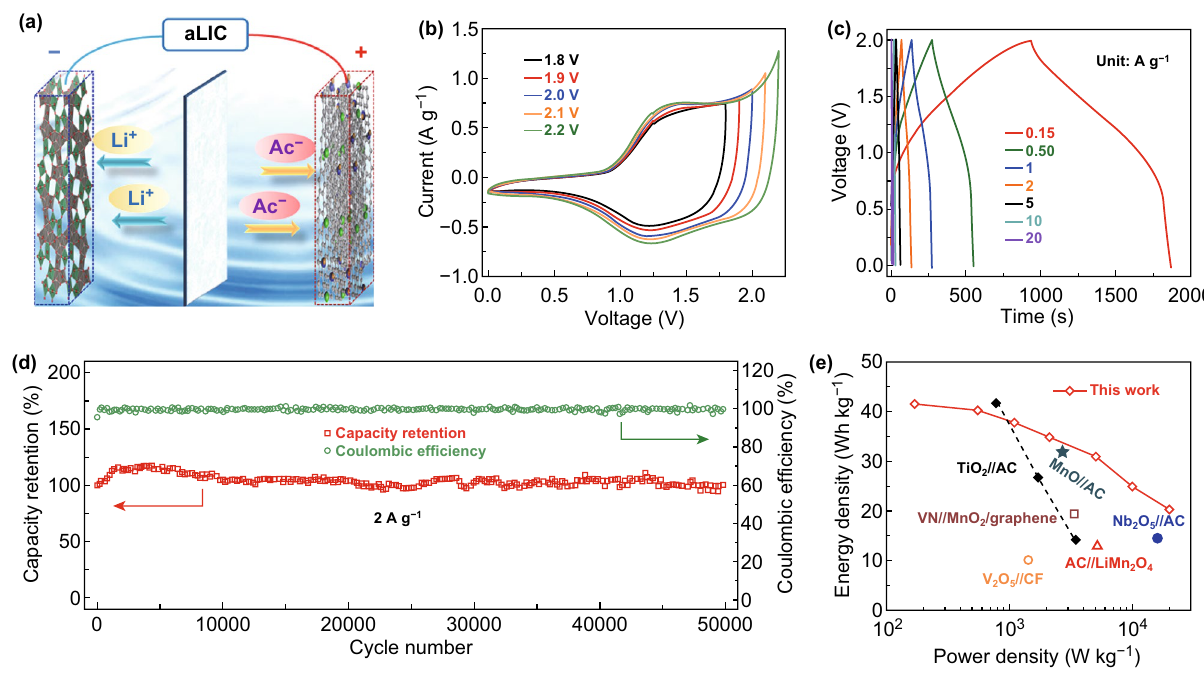
Fig. 5 Electrochemical evaluation of (+)OECG//NbWO(−) ALIC. a The diagrammatic sketch of electrochemical reaction mechanism. b CV curves of the ALICs collected at different voltage windows at fixed 5 mV s −1 . c GCD curves at different current density between 0 and 2 V. d Capacity retention and Coulombic efficiency for 50,000 cycles at a current density of 2 A g −1 . e Ragone plots for the OECG//NbWO ALICs and compared with other aqueous and non-aqueous LICs reported in the